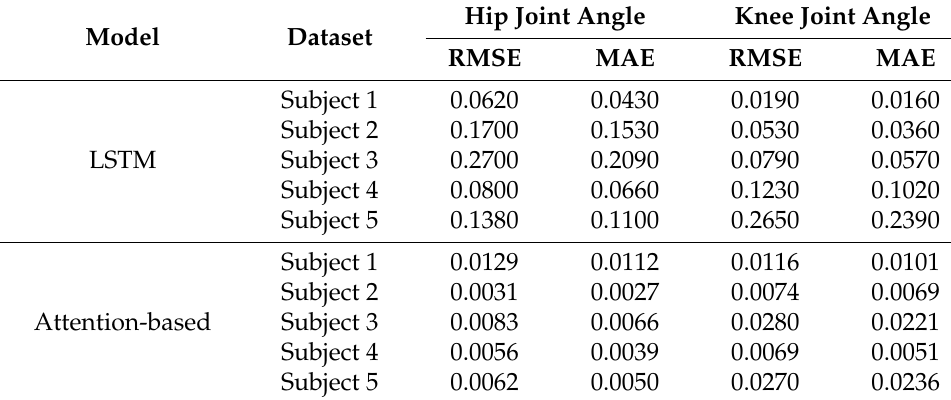
Table 3. Prediction performance of models on real data.